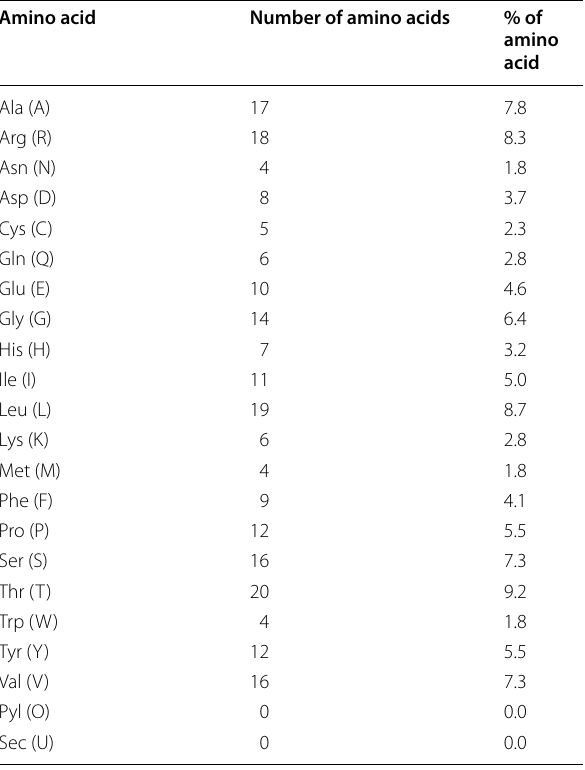
Table 2 Amino acid composition of